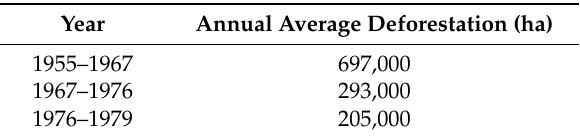
Table 1. Annual deforestation in Ethiopia from 1955–1979. Source: